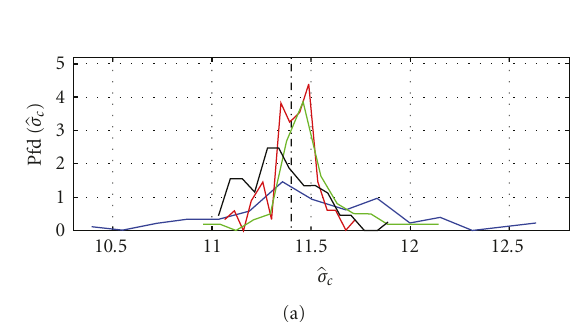
Figure 10: The empirical pdfs of the normalized noise STD estimates (cid:19) σ norm . Color settings are as in Figure